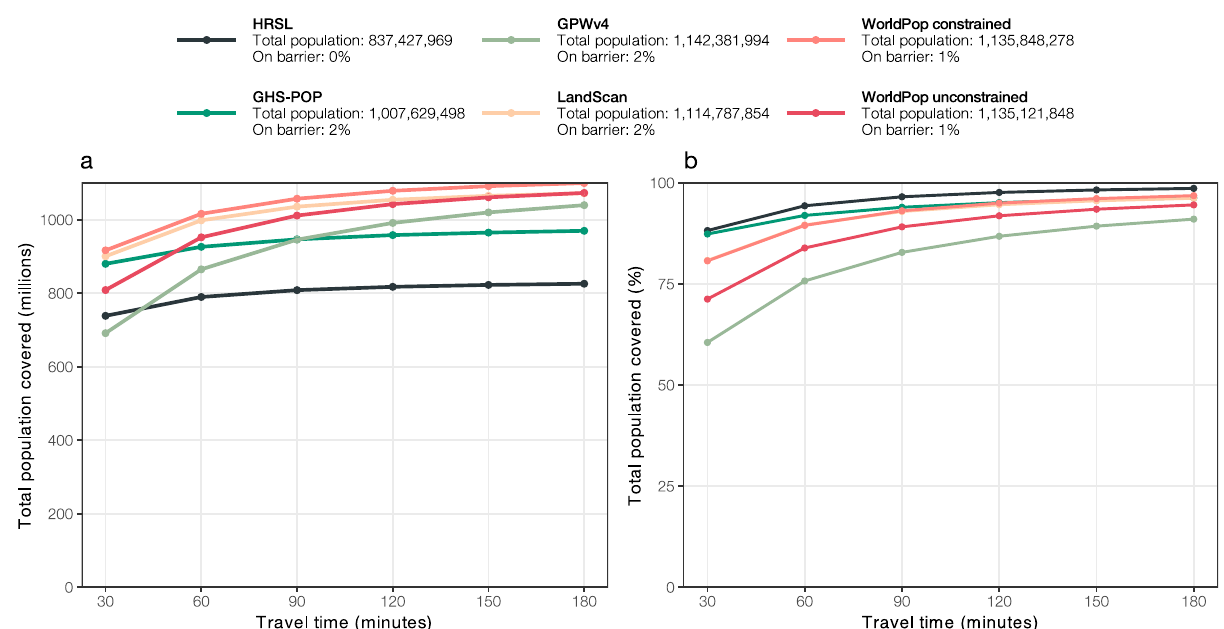
Fig. 1 Accessibility coverage at the sub-Saharan African level. Absolute ( a ) and relative ( b ) accessibility coverage for the six different gridded population data sets: HRSL, GHS-POP, GPWv4, LandScan, WorldPop top – down constrained, WorldPop top – down unconstrained. Total population is lower for HRSL because Ethiopia, Somalia, Sudan, and South Sudan are not included in the data set released in 2018. Legend indicates the total population falling on barriers (i.e., permanent waterbodies) and thus not included in the